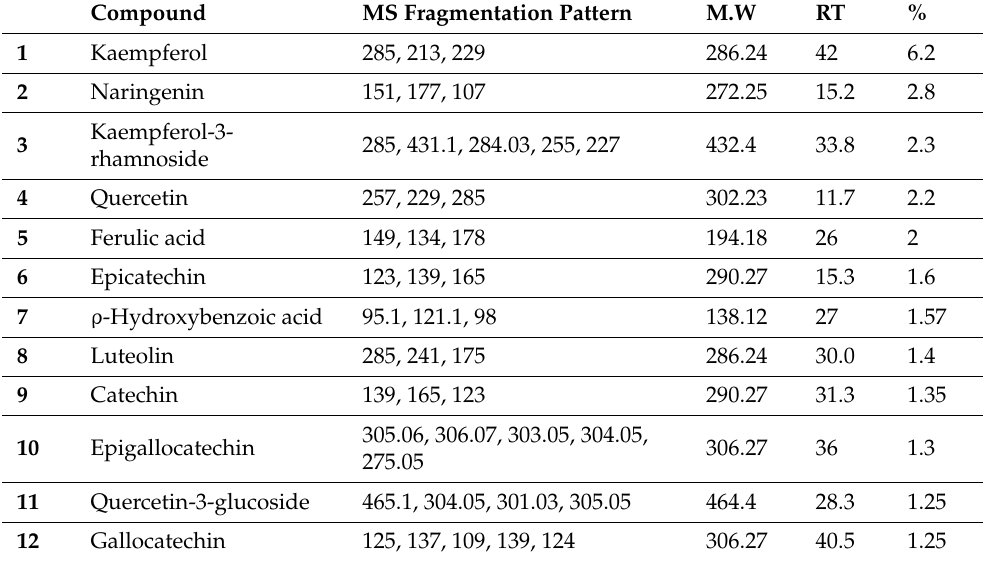
Figure 1. HPLC chromatogram of Ephedra foeminea aqueous extract eluted by 0.1% ( v / v ) formic acid in water and 0.1% ( v / v ) formic acid in acetonitrile. Table 1. Flavonoids and phenolic contents identified in Ephedra foeminea aqueous extract using